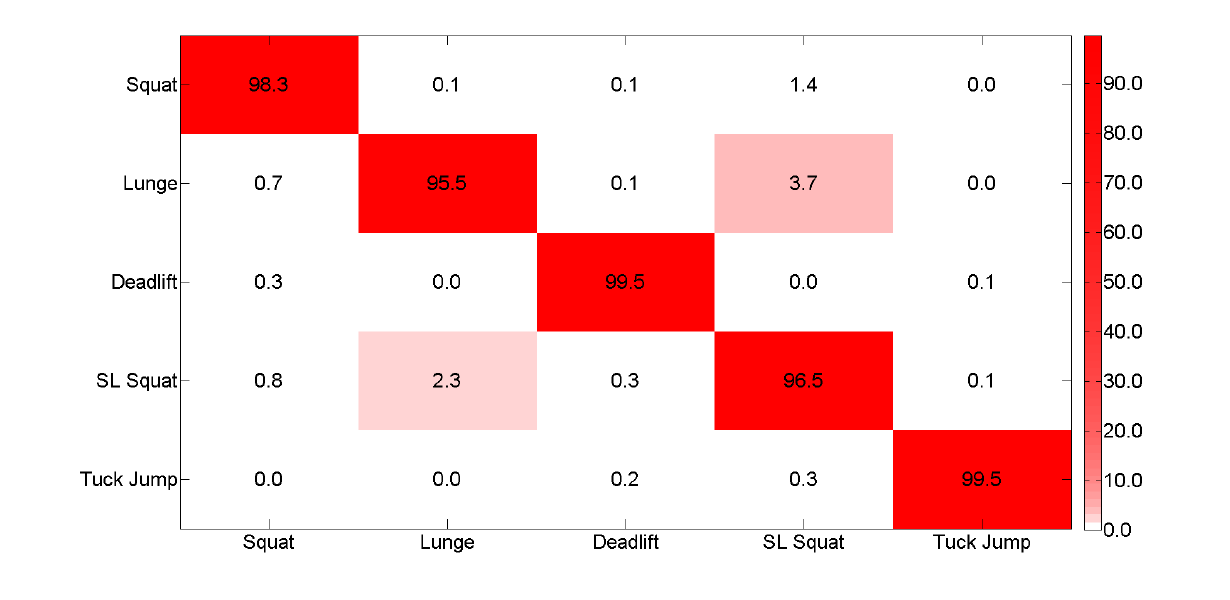
Figure 10. A lunge signal (a), a lunge signal misclassified as a single leg squat (b), and a single leg squat signal (c) for comparison.